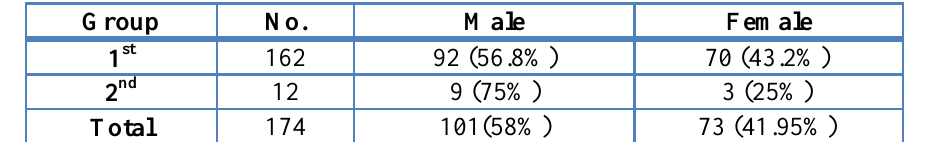
Table 1: Demographic data in the two groups.